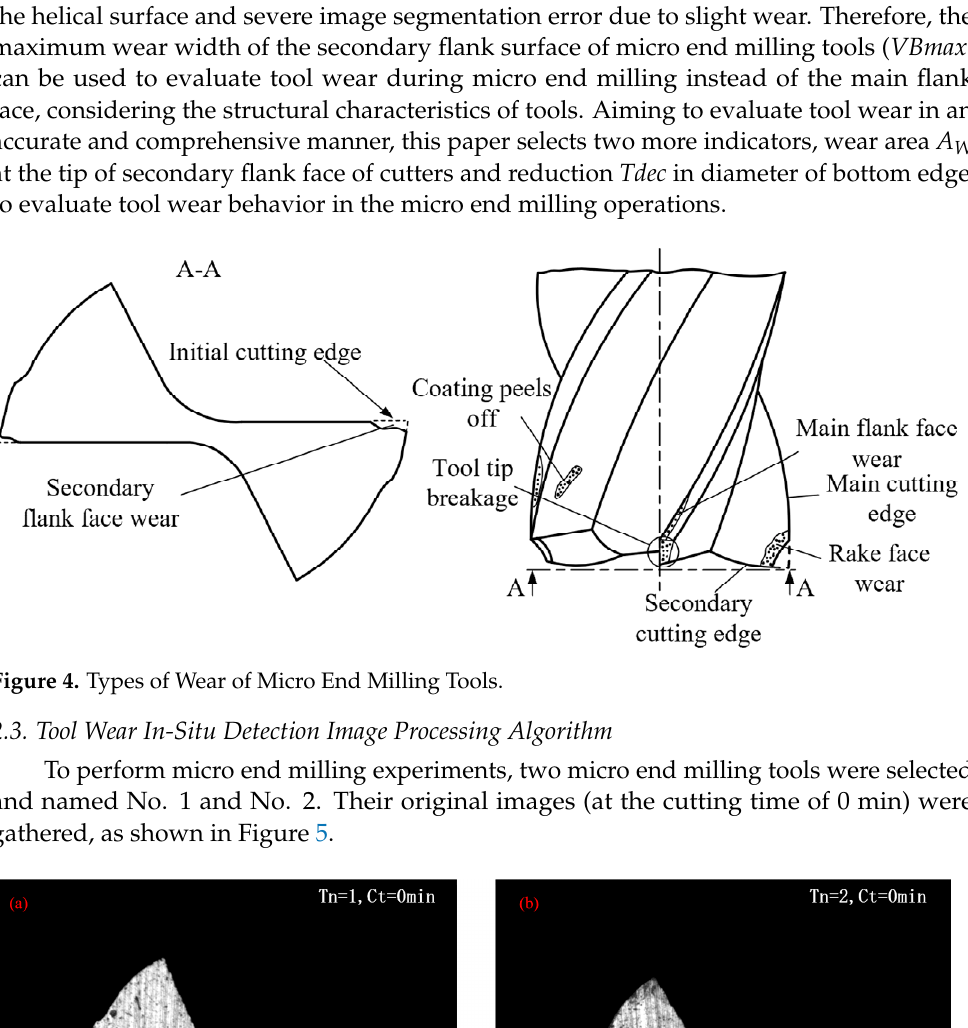
Figure 6. Template image developed for image processing algorithm of tool wear in situ monitoring of micro end milling tool cutter. Figure 7 shows the flow chart of wear image processing algorithm of the micro end milling tool, shown as Figure 6, and the effect of each step, which will be discussed later in this section.